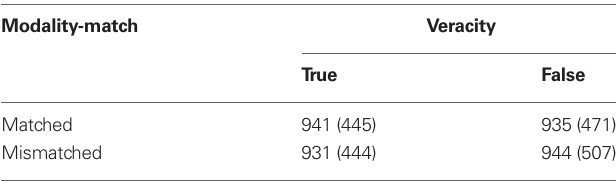
Table 4 | average reaction time (milliseconds) and standard deviation for the true/false judgments on target